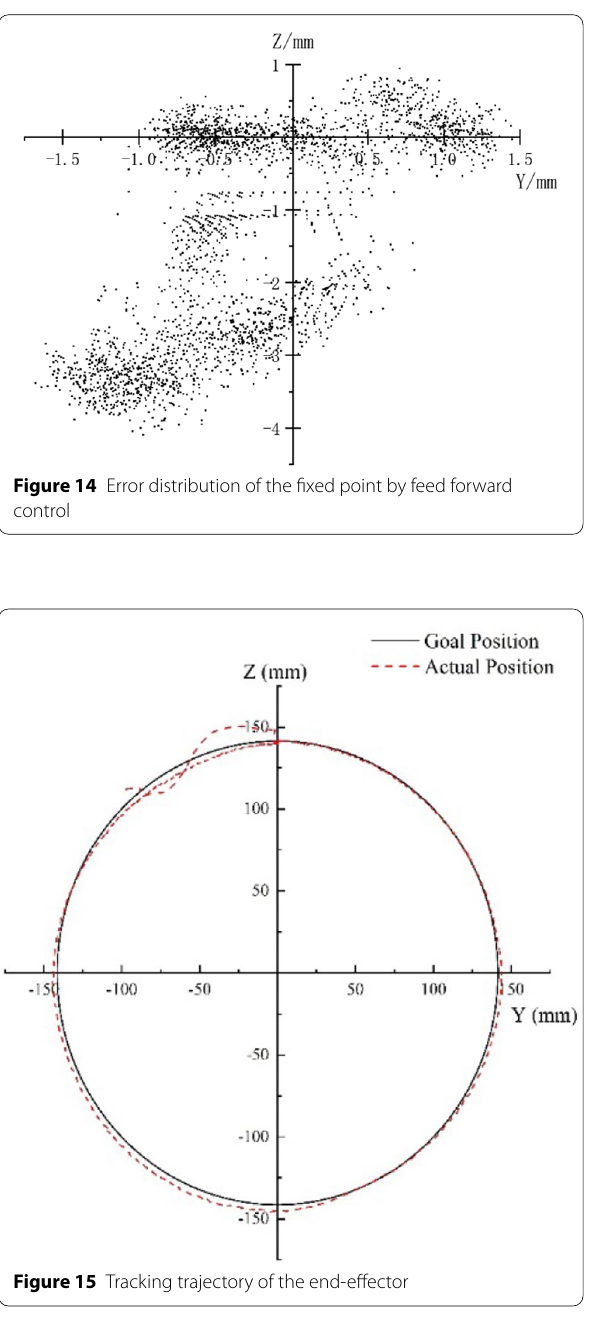
a reduction of 50.74%; and the average error of motor 3 was reduced from 0.0082 to 0.0043, with a reduction of 47.56%. The average error of the fixed point on the end effector was 2.8 mm, with a reduction of 30.0%; and the maximum error was 4.2 mm, with a reduction of 33.3%. The average trajectory tracking error of the end effector is 2.7 mm, with a reduction of 54.2%, and the maximum error is 6.6 mm, with a reduction of 32.0%.